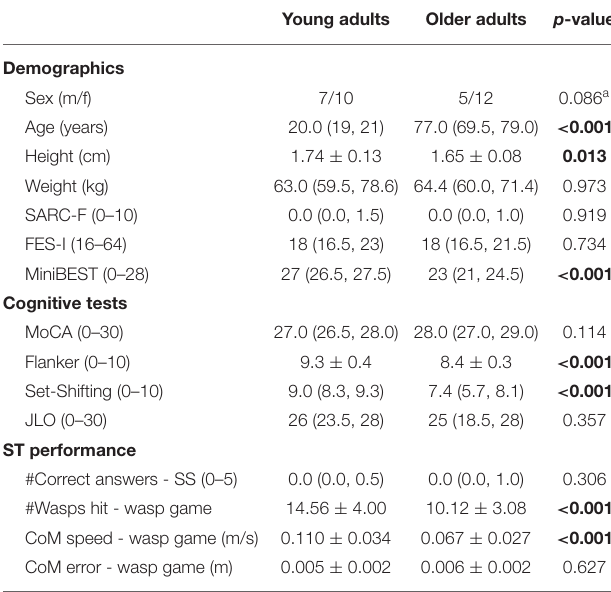
TABLE 1 | Demographics, cognitive test scores, wasp game ST, and serial subtraction ST performance for young and older